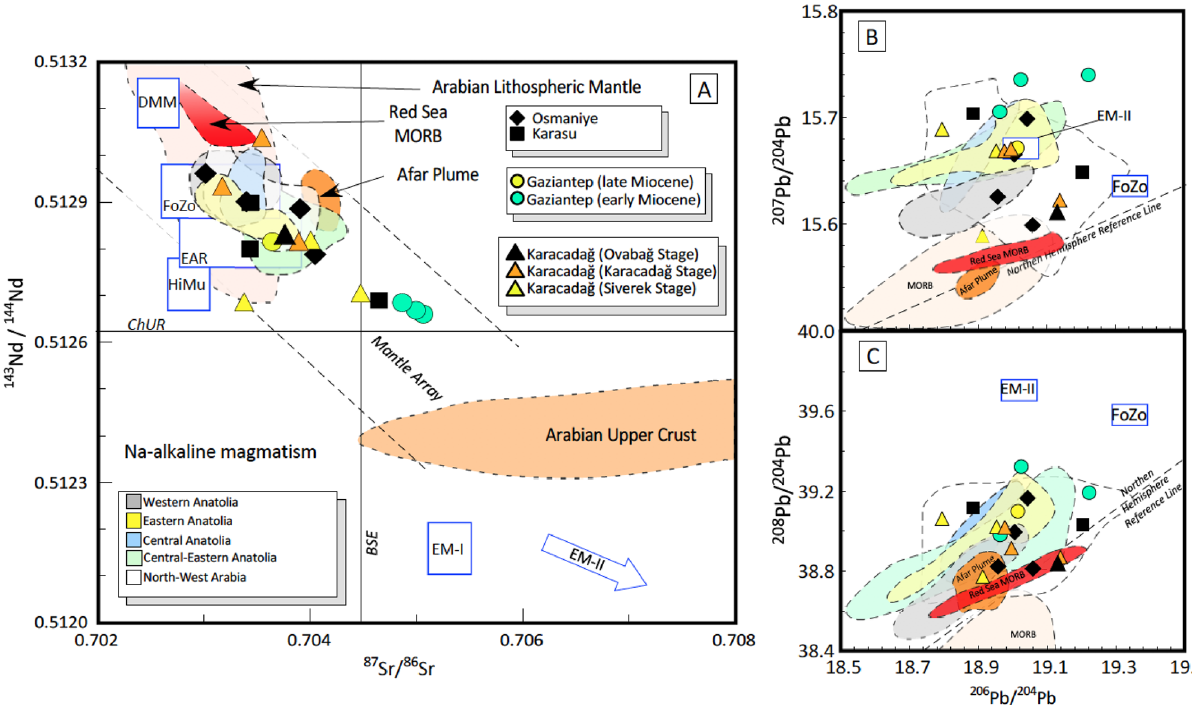
Figure 3. Sr–Nd-Pb radiogenic isotope compositions of Neogene volcanic rocks around Anatolia-Africa- Arabia plate borders. ( A ) 143 Nd/ 144 Nd vs. 87 Sr/ 86 Sr isotopic ratios for the studied rocks. BSE is the Bulk Silicate Earth; ChUR is the Chondritic Uniform Reservoir.; ( B , C ) 207 Pb/ 204 Pb vs. 206 Pb/ 204 Pb and 208 Pb/ 204 Pb vs. 206 Pb/ 204 Pb diagrams. Dashed line indicates the Northern Hemisphere Reference Line (NHRL). Mantle end- members: DMM (Depleted MORB Mantle); FoZo (Focal Zone), HiMu = High µ (µ = 238 U/ 204 Pb ratio), EM-I (Enriched Mantle I), and EM-II (Enriched Mantle II). EAR = European Asthenospheric Reservoir. NHRL and fields of Mantle end-embers same as Agostini et al. 27 . Arabian Upper Crust, Arabian Lithospheric Mantle, Red Sea MORB, and Afar plume as in Ma et al. 28 . Fields showing the isotopic composition of Na-alkaline volcanic rocks are from: Kula (Western Anatolia) 29 , Cappadocia (Central Anatolia) 30 , Sivas, Kangal and Arguvan (Central-Eastern Anatolia) 24 ; Elazığ (Eastern Anatolia) 25 ; Al Ghab, Homs, Aleppo, Shin Plateau and Harrat Ash Shaam (Arabian Plate) 28,31